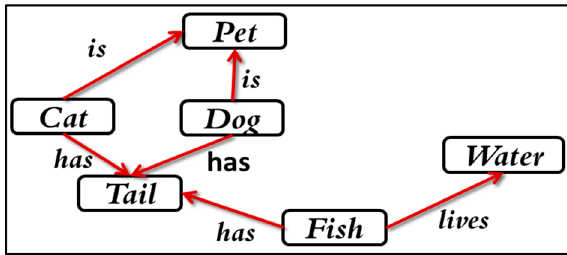
Figure 4. Semantic network retrieving animals source information.